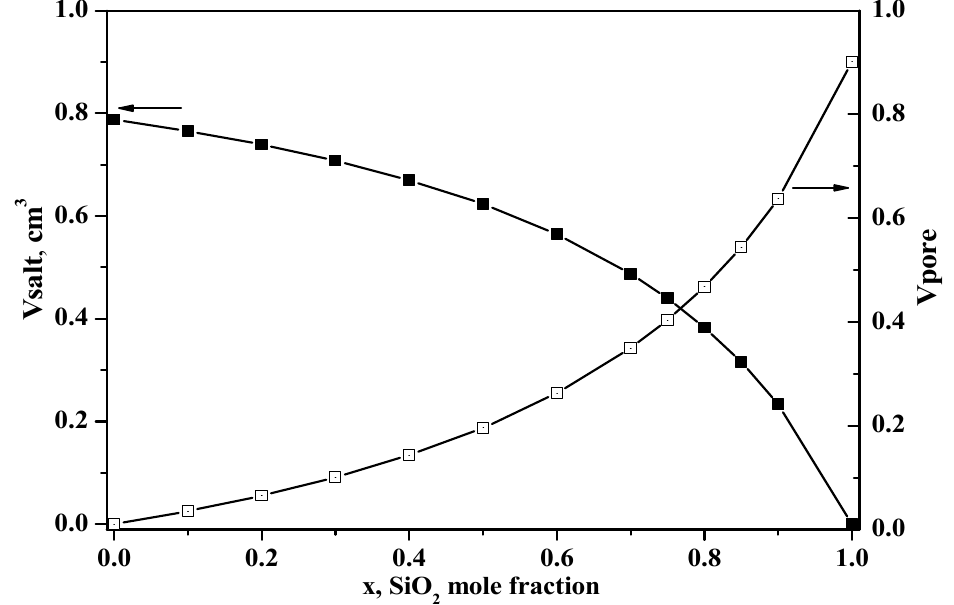
Figure 3. The variation in the total volume of Et 4 NHSO 4 (V salt ) and the total volume of silica pores (V pore ) per 1 g of the composite with the SiO 2 mole fraction in the (1 − x)Et 4 NHSO 4 − xSiO 2 composites. The pore-filling effect was supported by the results of the scanning electron microscopy studies presented in Figure 4. As can be seen from the figure, the initial Et 4 NHSO 4 powder consisted of coarse crystalline particles 100–300 μ m in size (Figure 4a).